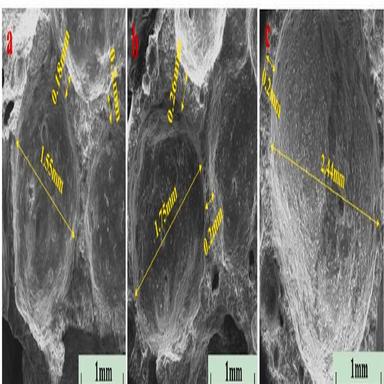
Effect of different water-repellents on the pore structure of AAC materials: (a) SP, (b) OC, and (c) ZS.